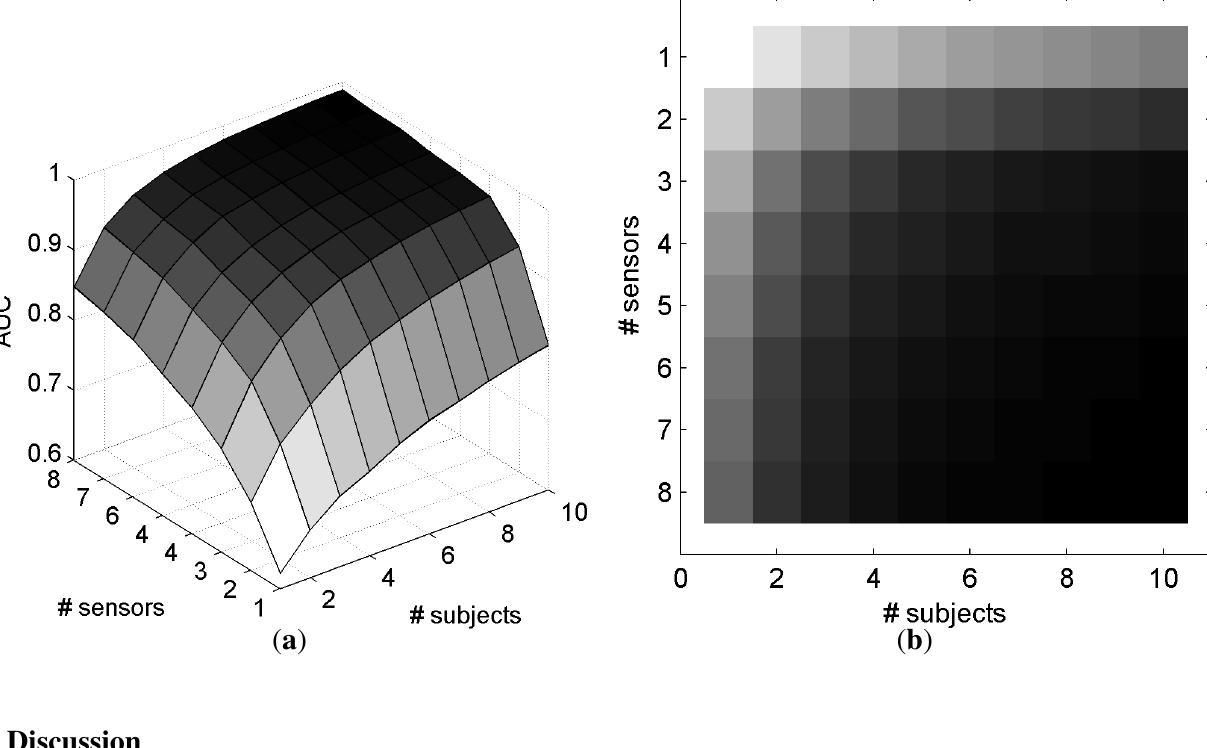
method individual